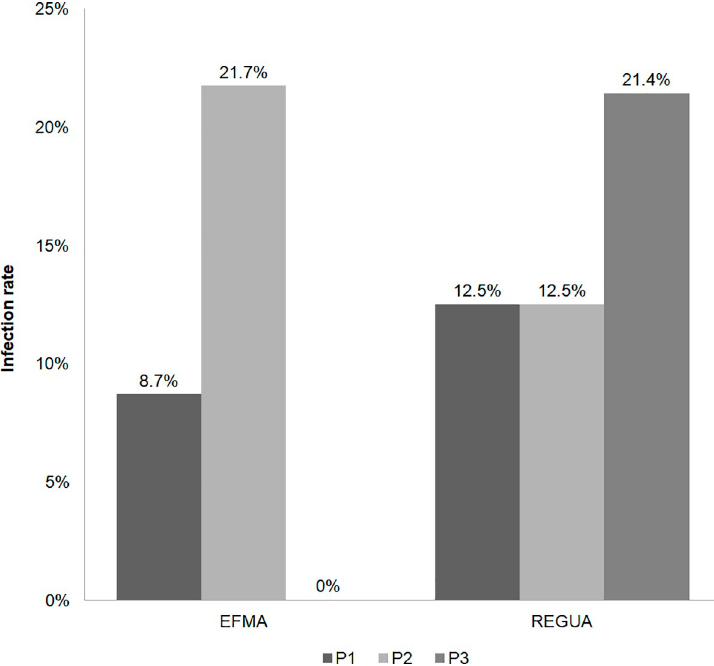
Fig 2. Trypanosomatid infection rate in bats captured at REGUA (Reserva Ecolo´gica Guapiac¸u´) and EFMA (Estac¸ ã o Biolo´gica Fiocruz Mata Atlaˆntica), Rio de Janeiro state, Brazil. Infection rates by sampling site for each study area are shown in columns. Sites P1, P2 and P3 are represented by